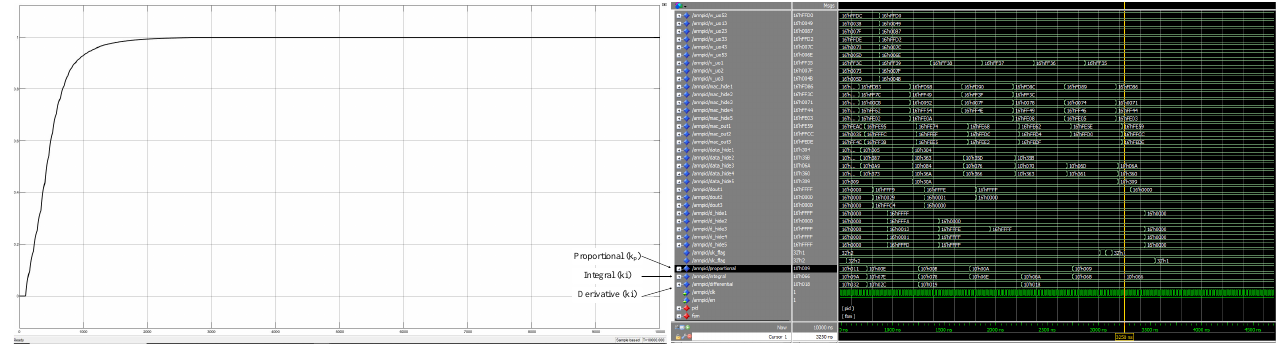
Figure 21. Step response curve graph and control parameter change graph without interference.